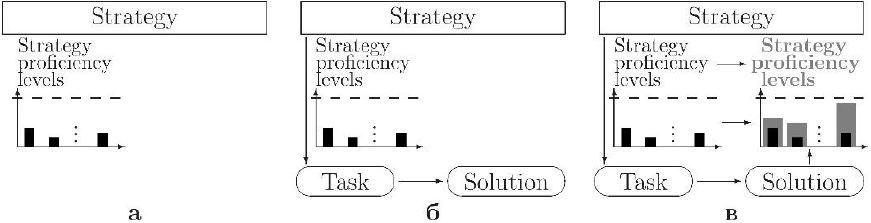
Fig. 6. Illustration to the management of parameters the ownership of the